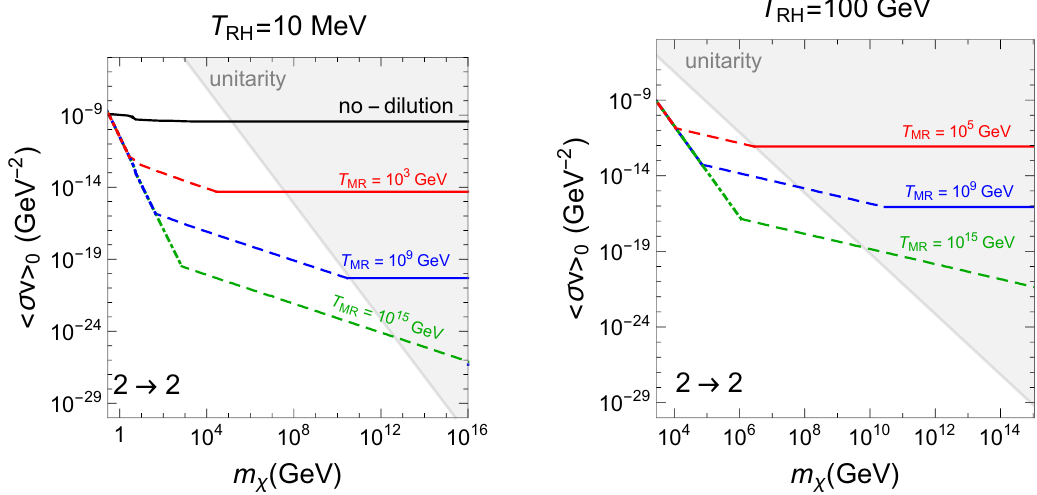
Figure 2 . Region in the h σ 2 → 2 v rel i 0 and m χ plane in which the observed value of the DM density Ω DM h 2 = 0 . 12 is satisfied, for dominantly 2 → 2 DM annihilations, with an intermediate matter dominated epoch, for the scenarios with T RH = 10 MeV (left panel) and with T RH = 100 GeV (right panel). The results are shown for different values of the matter-radiation equality temperature T MR . In each case, DM freeze-out may take place during radiation domination (solid lines), nearly stable matter domination (dashed lines), or decaying matter domination epochs (dot-dashed